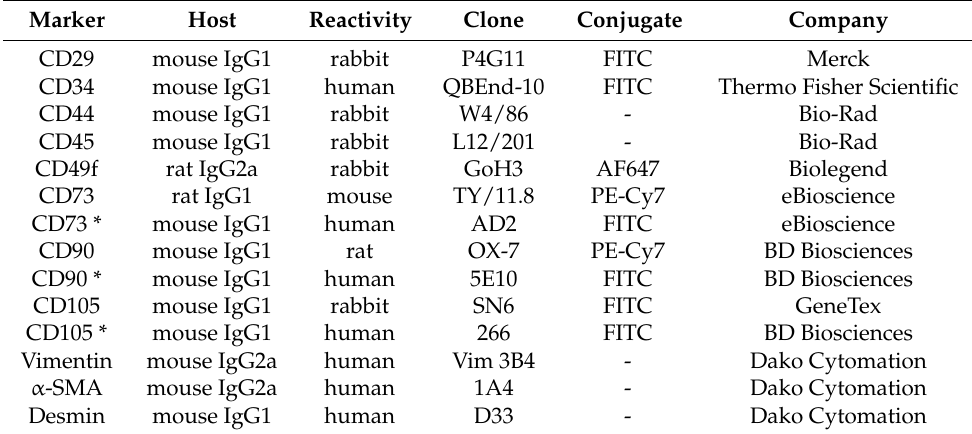
Table 1. List of primary antibodies used for flow